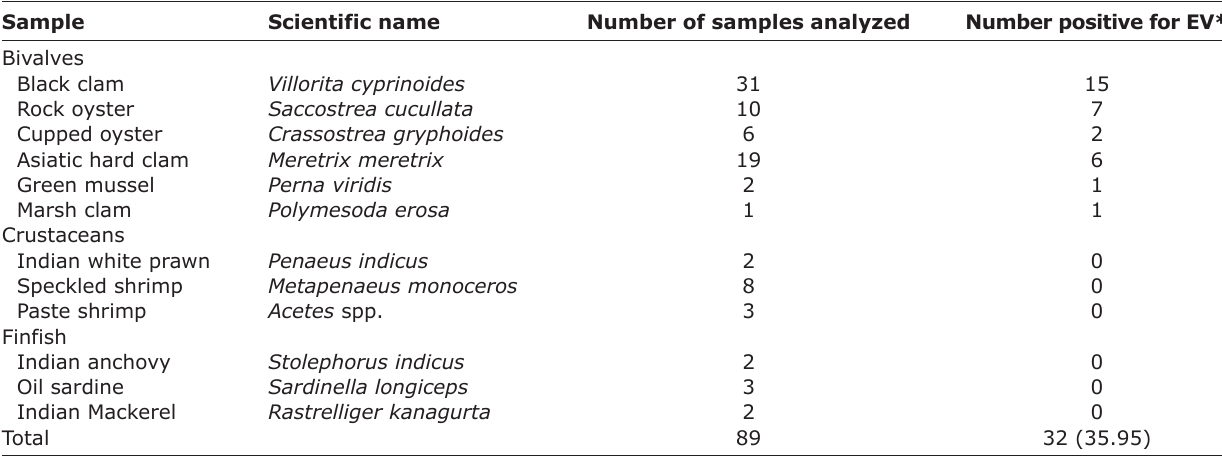
Table-1: Occurrence of EV in different samples analyzed in this study. Sample